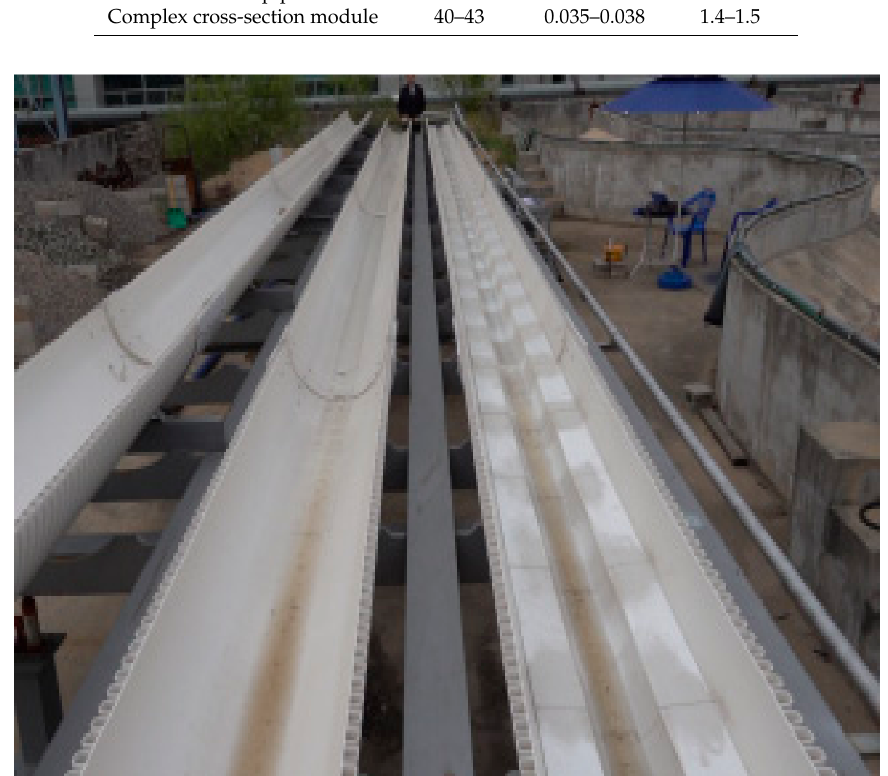
Figure 8. Transportation of the sediment on the experimental sewer pipe